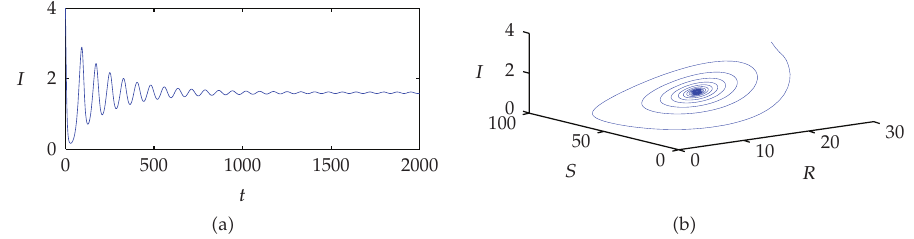
Figure 8: Temporal behavior of the infected and corresponding three-dimensional phase are plotted for the system (cid:2) 1.1 (cid:3) subject to 1 < R 0 < R c . The parameters like in Figure 5 but α (cid:8) 0 . 055, γ (cid:8) 0 . 75, and τ (cid:8) 1 . 5 with initial value (cid:2) 25, 4, 20 (cid:3)